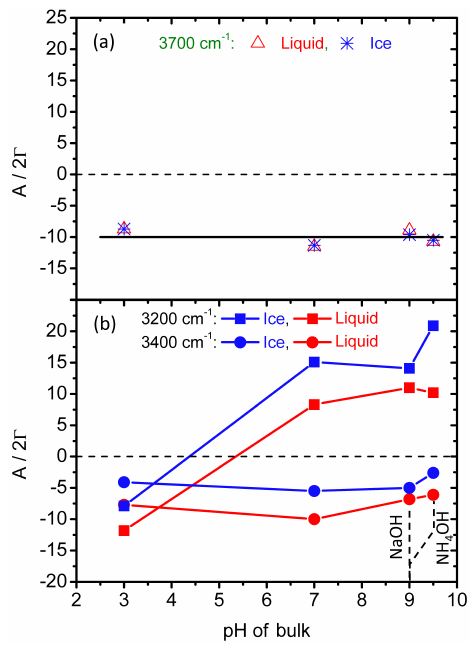
Figure 4. Amplitudes of indicated resonances divided by their width as a function of pH for (a) the 3700cm − 1 resonance and (b) the 3200 and 3400cm − 1 resonances, all three inferred from Lorentzian fits to the spectra of Fig. 3. Low and high pH may restrict the freedom of the interfacial molecules to structure themselves in the ice